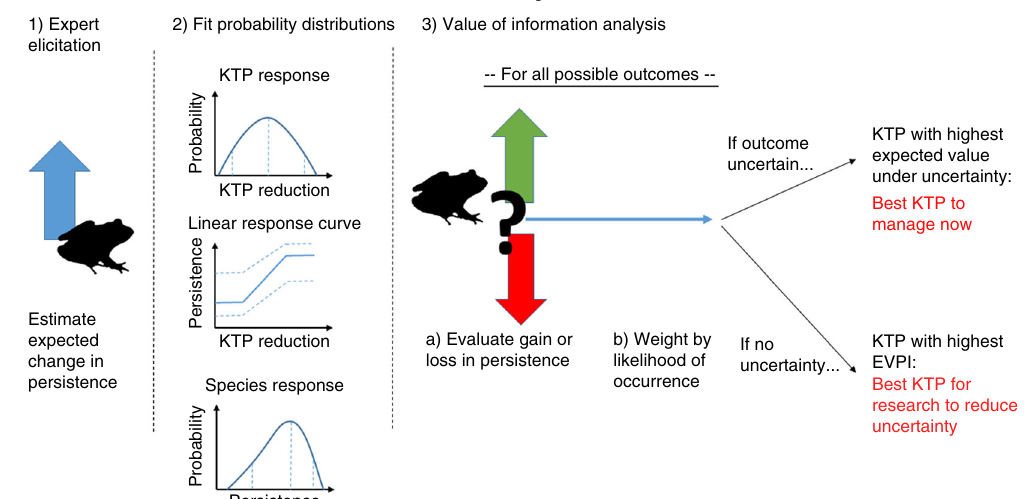
Fig. 9 Schematic of the process used to determine the best KTPs for management and